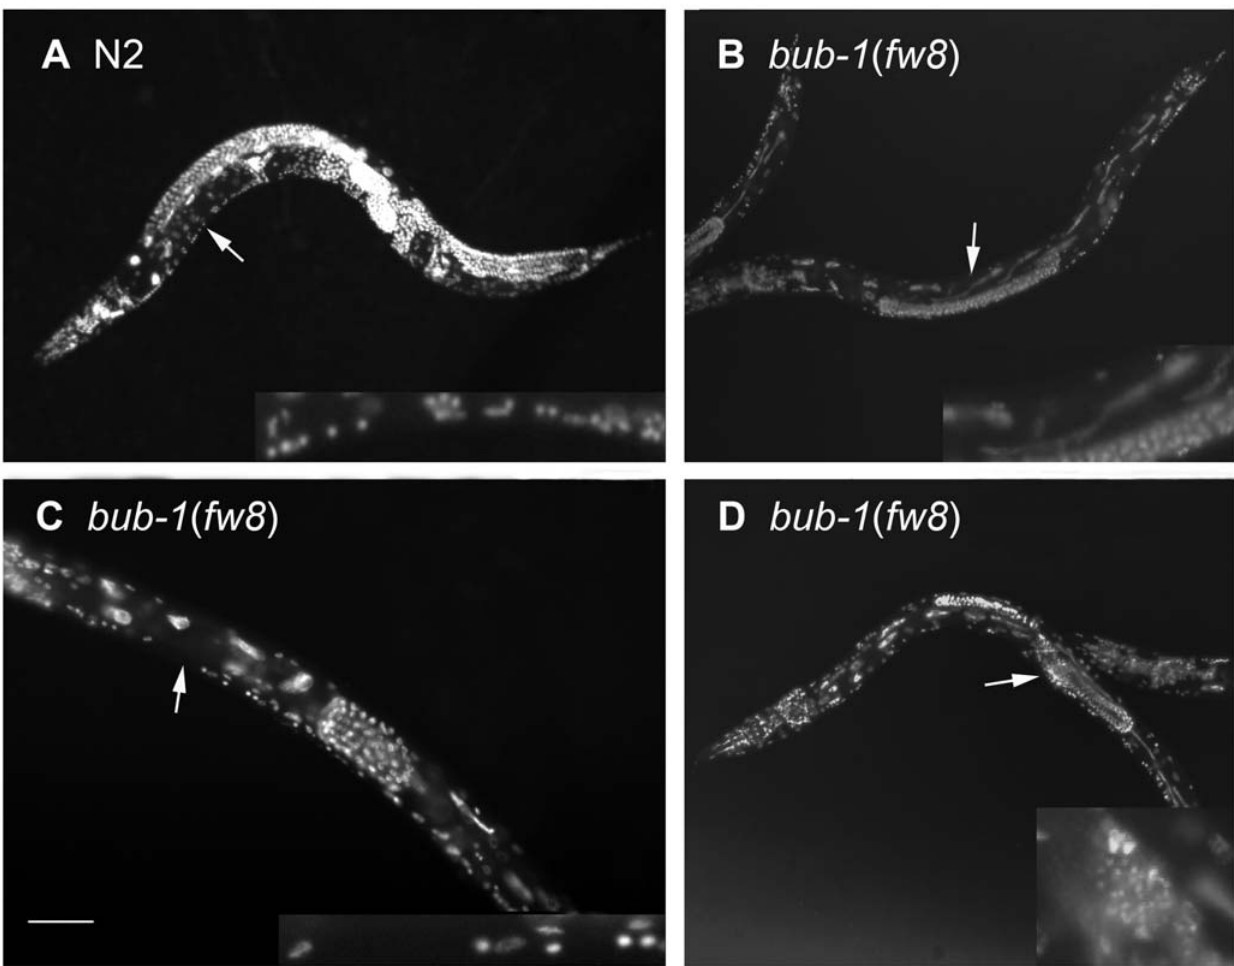
Figure 5. DAPI Staining Images of bub-1 Mutants. (A) wild-type animal N2. (B) The arrow indicates the elongated intestine cell in bub-1 ( fw8 ) animal. (C) Compared with N2 animals, the ventral cord of bub-1 ( fw8 ) had fewer neuron numbers (shown by the insert). (D) The arrow indicates the sperm in the bub-1 ( fw8 ) mutant. The bar represents 100 m m.